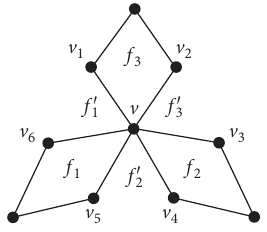
Figure 5: Illustration for the proof of case